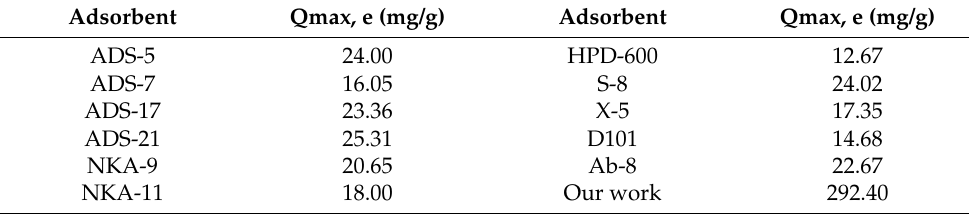
Table 1. Resveratrol adsorption capacity of different